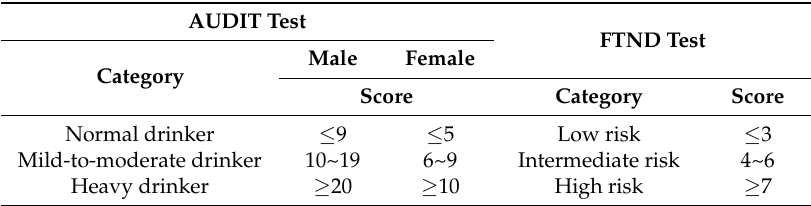
Table A1. Criteria and score in the AUDIT and the FTND